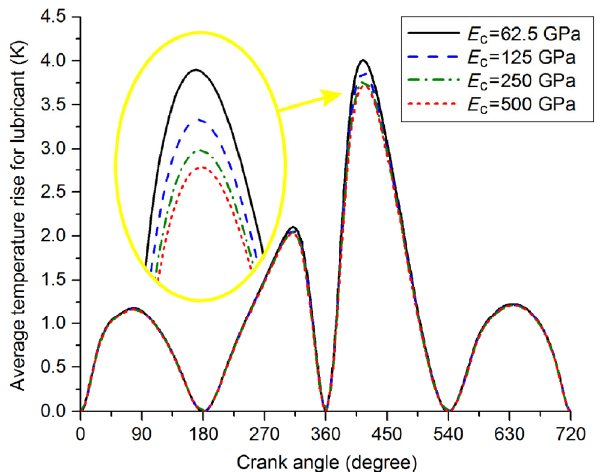
Fig. 5 The variation of average temperature rises for the lubricant when the untextured conjunctions with different elasticity modulus of coatings are under the cold engine